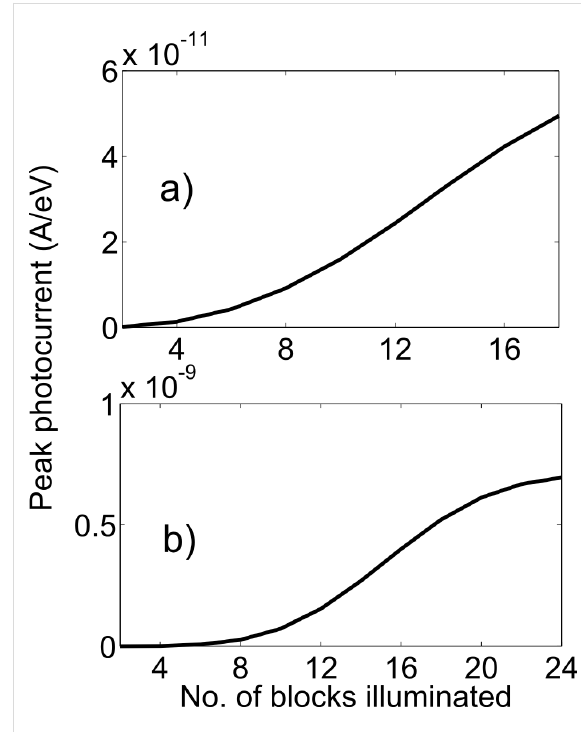
Figure 7: Variation of peak photocurrent with number of blocks illumi- nated. (a) zigzag structure, (b) armchair